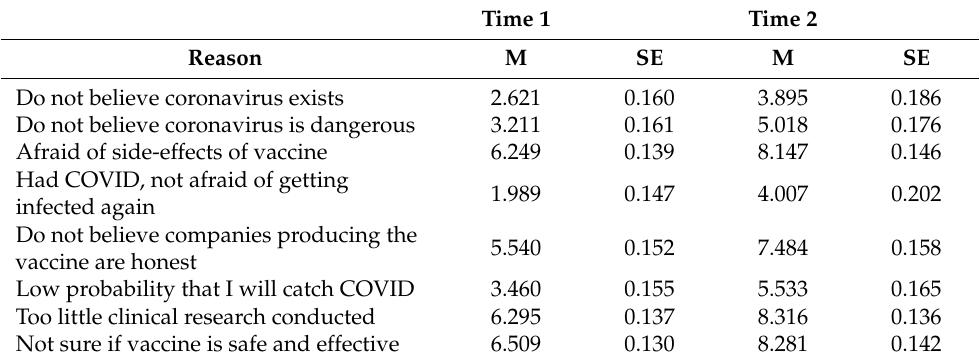
Table 2. Changes in reasons to not get vaccinated between Time 1 and Time 2 in the consistently anti-vaccine and undecided samples.